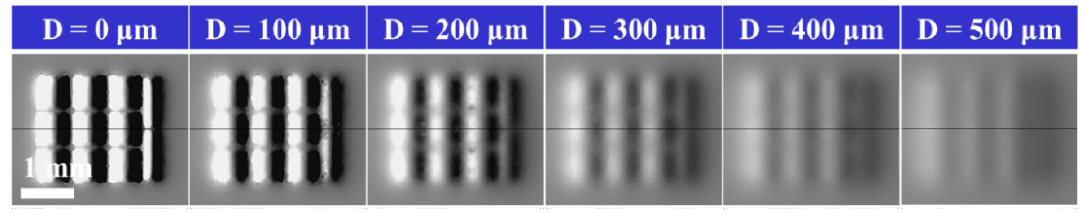
Figure 10. Sensing distance by FEM analysis software. Tag identification is possible even at 400 μm, which is difficult to identify with an actual MO sensor under ideal conditions.